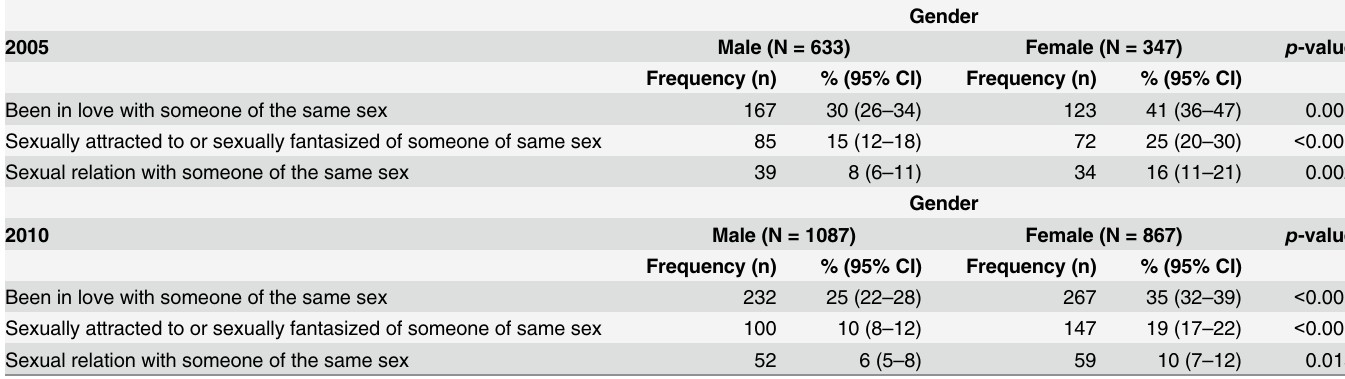
Table 2. Prevalence of same-sex sexuality by gender among university students in Uganda, 2005 (n = 980) and 2010 (n =